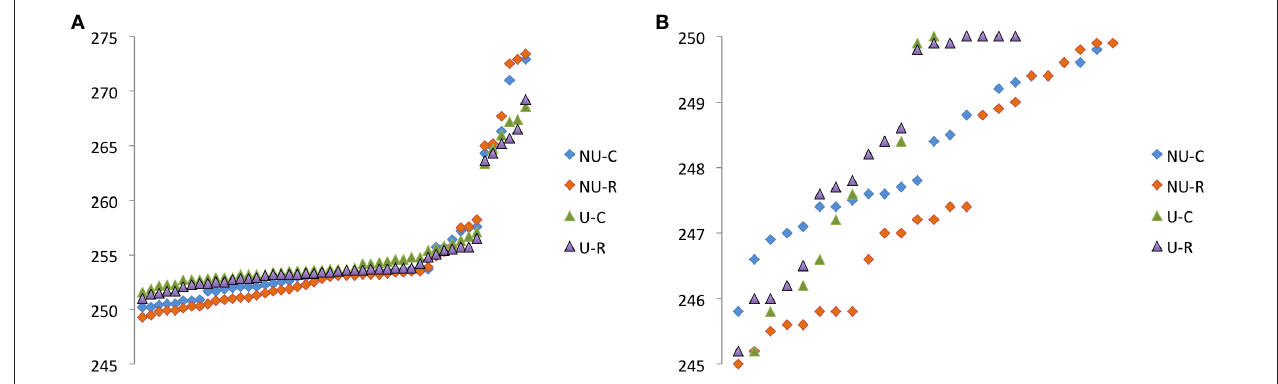
FIGURE 2 | Results of 48 configurations when the variation operator combinations NU-C, NU-R, U-C, and U-R are used. (A) Sorted according to the mean race time (in s) of fastest strategy. Shown are all 192 means. (B) Sorted according to the minimal race time (in s) of fastest strategy. Excerpt shows race times ≤ 250s.